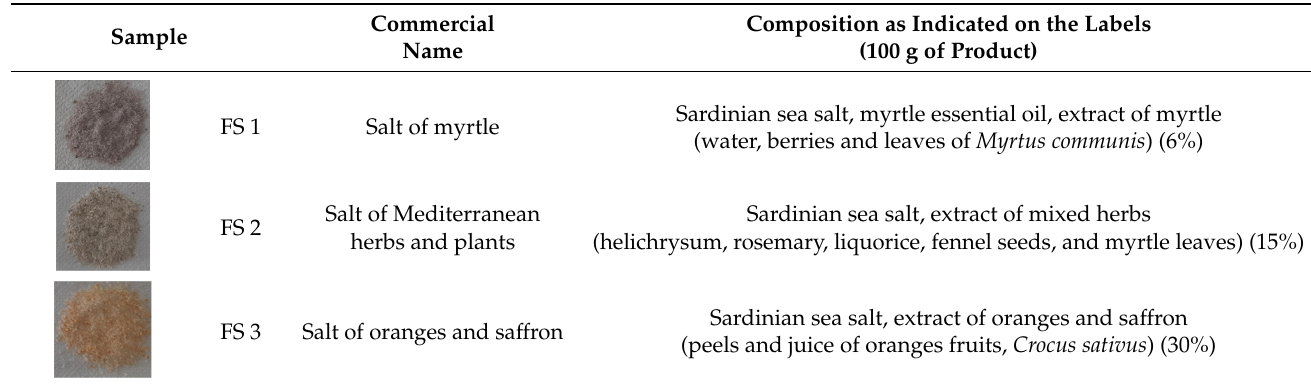
Table 1. Composition and digital images of different commercial flavored sea salts indicated per 100 g [3].